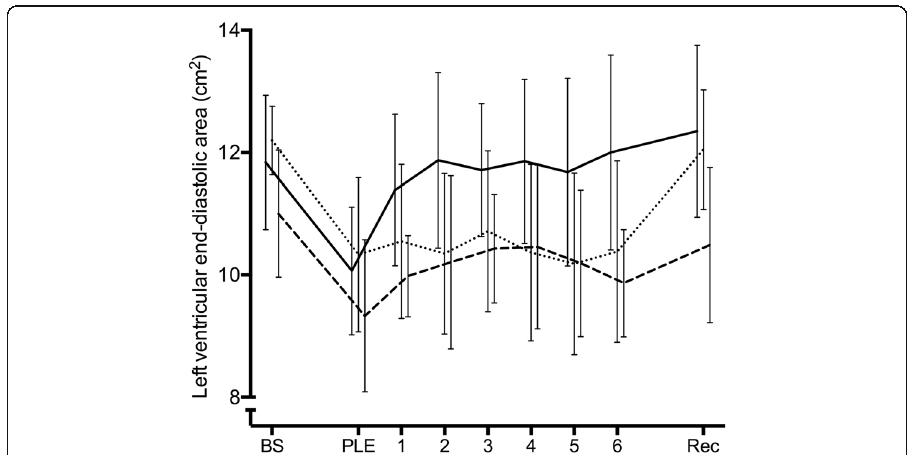
(dashed line) and placebo (dotted line), and finally at recovery after pleurocentesis (Rec). Left ventricular end-diastolic area decreased due to pleural effusion, which was normalised by fluid loading and norepinephrine infusion.